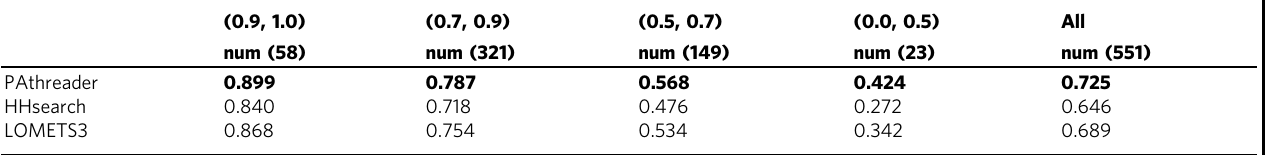
Table 1 TM-score of template recognition on 551 tested proteins.